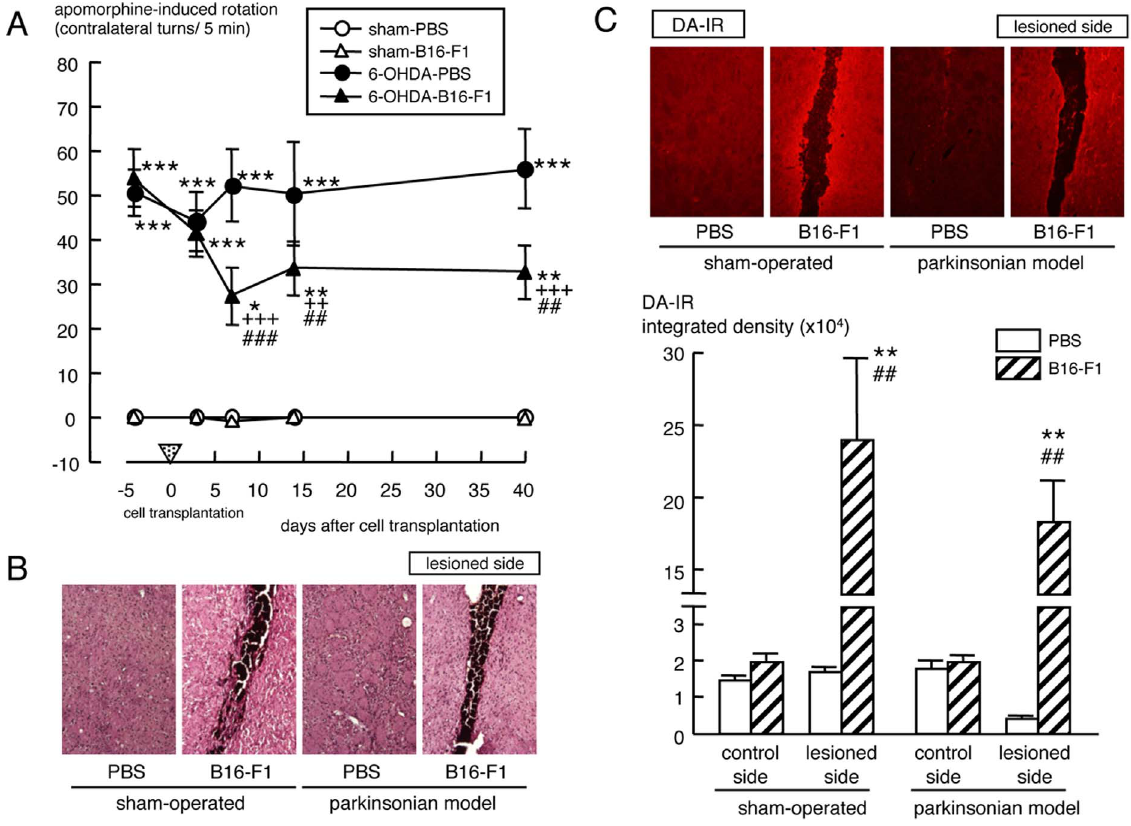
Figure 2. Effects of intrastriatal transplantation of B16-F1 melanoma cells in hemi-parkinsonian rats. (A) Rotation behavior towards contralateral side for 5 min at 5 min after injection of apomorphine (0.1 mg/kg, s.c.) was tested at 3, 7, 14 and 40 days after transplantation of B16-F1 melanoma cell (5 6 10 5 cells/4 m l PBS X2) into the right lateral striatum of hemi-parkinsonian rats or sham-operated controls. Values are means 6 SEM of 3–4 rats. * p , 0.05, ** p , 0.01, *** p , 0.001 vs. each sham-PBS, ++ p , 0.01, +++ p , 0.001 vs. each 6-OHDA-PBS, ## p , 0.01, ### p , 0.001 vs. each pre- transplantation of B16-F1 cells. Representative photographs of hematoxylin-eosin-staining (B) and DA-IR (C) of the striatal area around the transplant at 52 days after intrastriatal transplantation of B16-F1 melanoma cells in hemi-parkinsonian rats and sham-operated controls. (C) Lower panel shows means integrated density of DA-IR 6 SEM (n=3–4). ** p , 0.0001 vs. control side of each treated group. ## p , 0.0001 vs. side-matched PBS-injected control